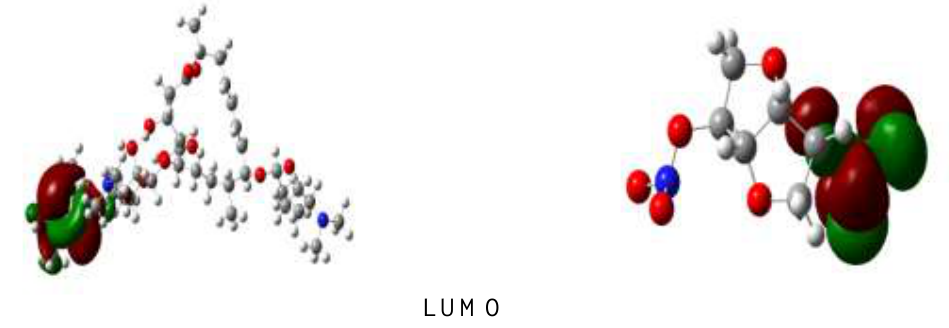
Figure 12: The energy levels (HOMO-LUMO) orbitals of the studied inhibitors (1 and 2).